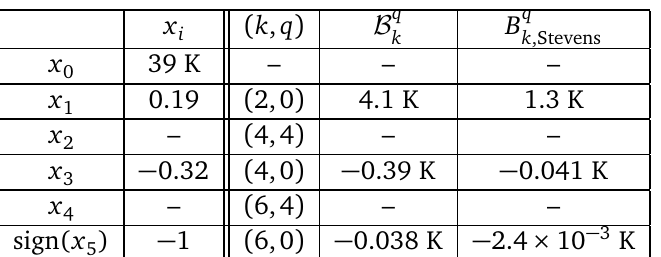
Table 2: Stevens parameters for PrAgSb and B q are defined in Sec. 2. Note that the CNN is unable to learn the k ,Stevens